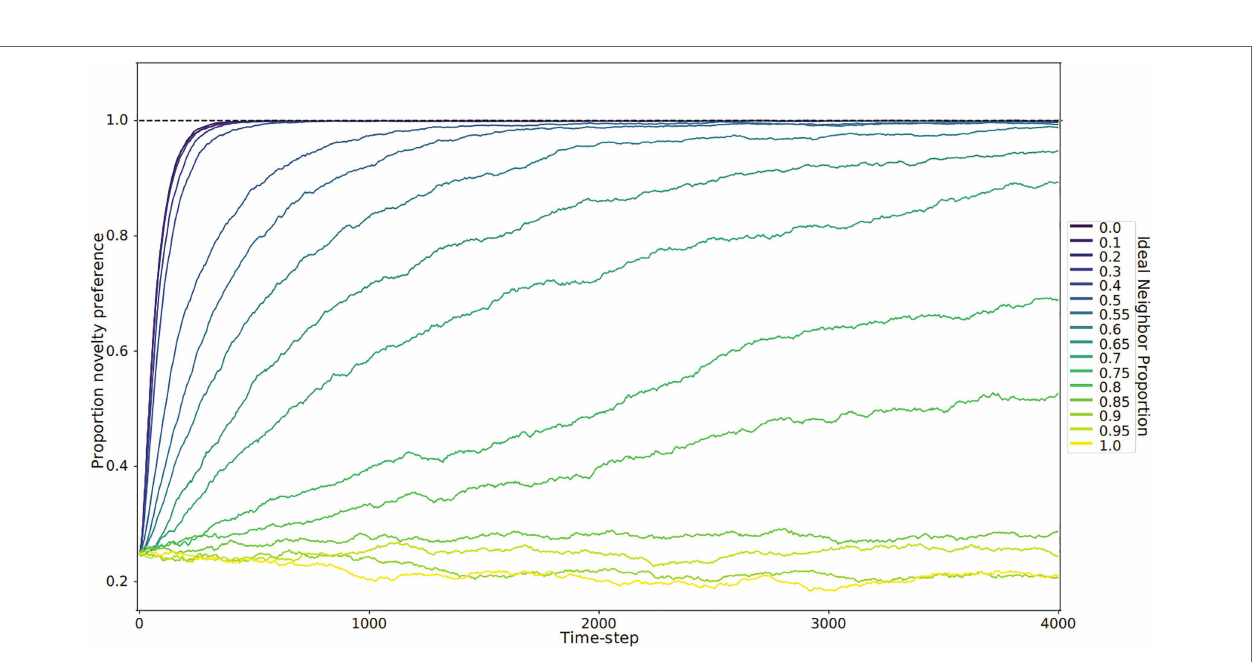
FIGURE 3 | Novelty preference over time by ideal neighbor proportion. Each line represents the average of five replicates. When individuals with a rare cultural type are more likely to leave offspring (low ideal neighbor proportion), there is strong selection for novelty preference (blue lines). Populations with a high ideal neighbor proportion experience little selection for or against novelty preference (yellow and light green